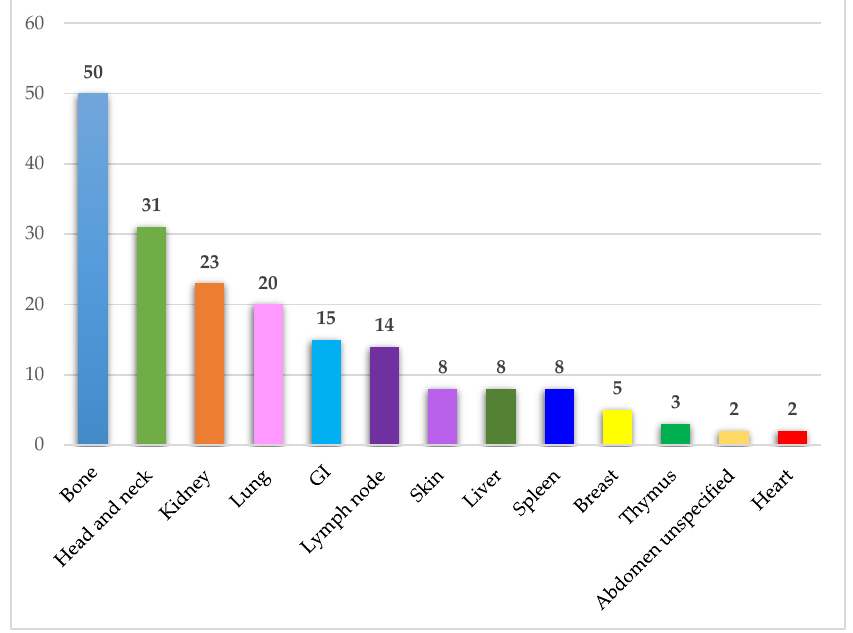
Figure 4. Affected organ systems. The figure demonstrates the number of identified cases in different organ systems. Abdomen unspecified includes one case of ascites and one case of a retroperitoneal mass. Abbreviations: GI—Gastrointestinal tract.